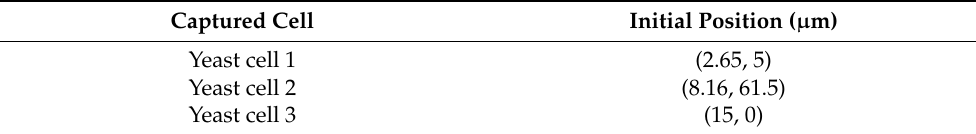
Table 3. Initial position of the controlled cells.